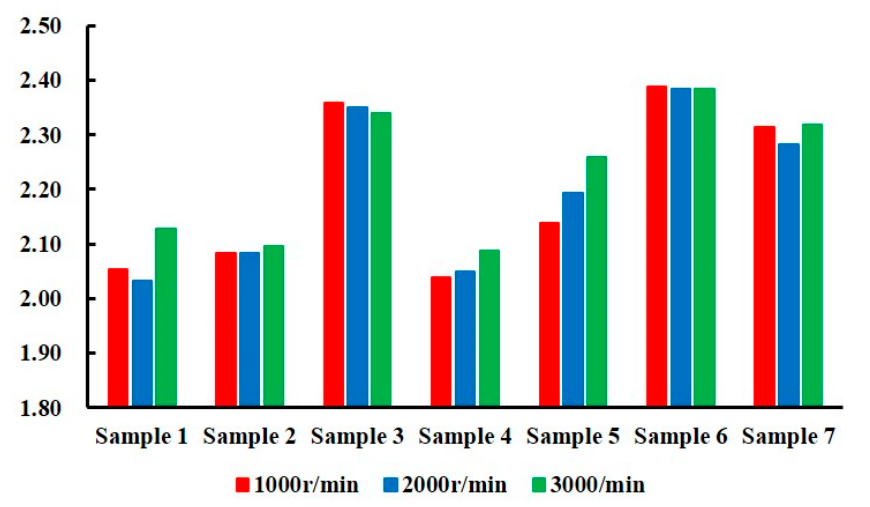
Figure 10. Trends of D l in different centrifugal speed.